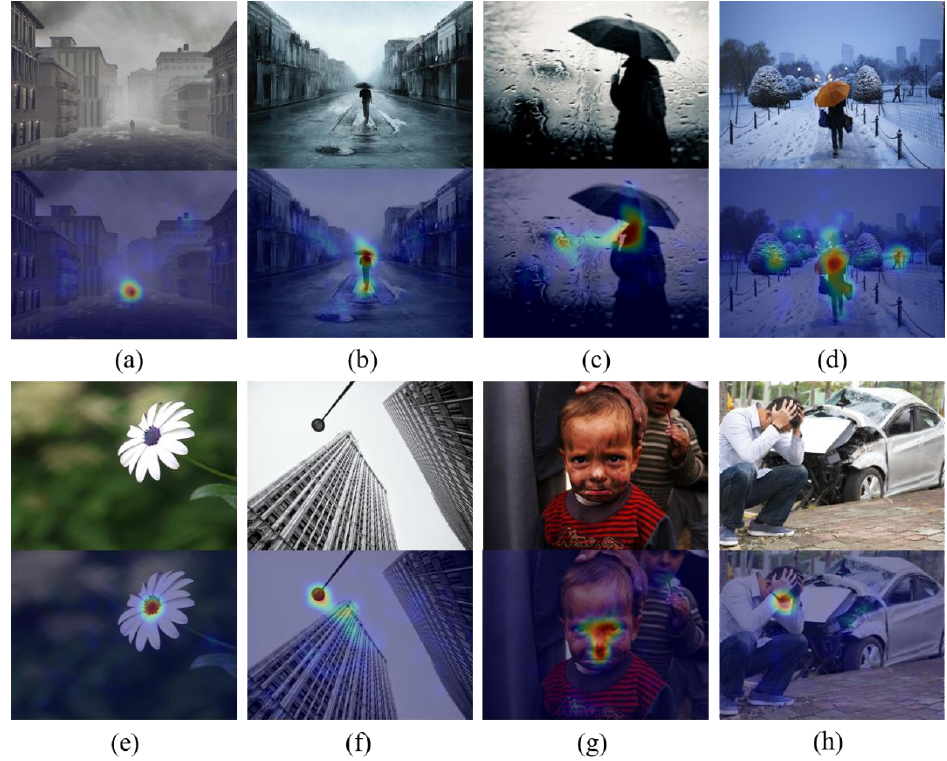
Figure 1. Images are from the emotional attention dataset EMOd [1]. In the eight columns of images from ( a – h ), the above is the original image, and the below is the eye-tracking focus of the image. Images ( a – d ) represent the backs of people, but their scales are significantly different, representing the different size of objects in the images. Images ( e – h ) represent different levels of semantic content from simple to complex.